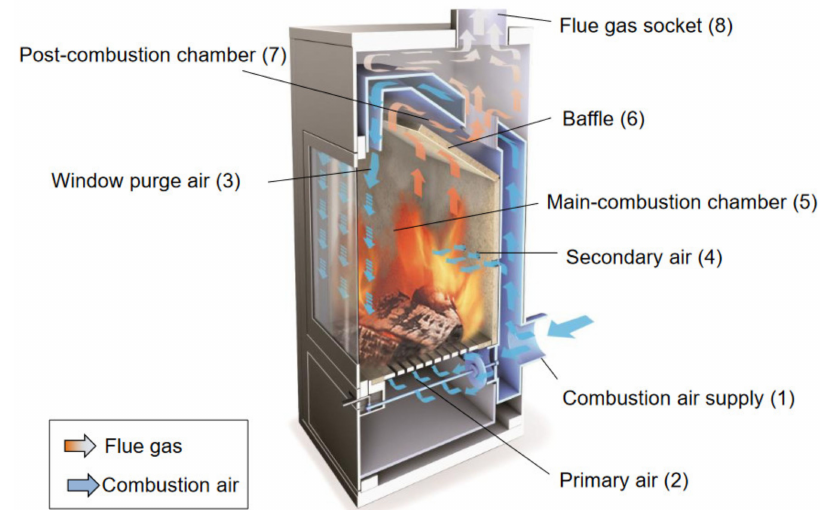
Figure 4. Illustration of air supply and air staging concept of a room-sealed chimney stove